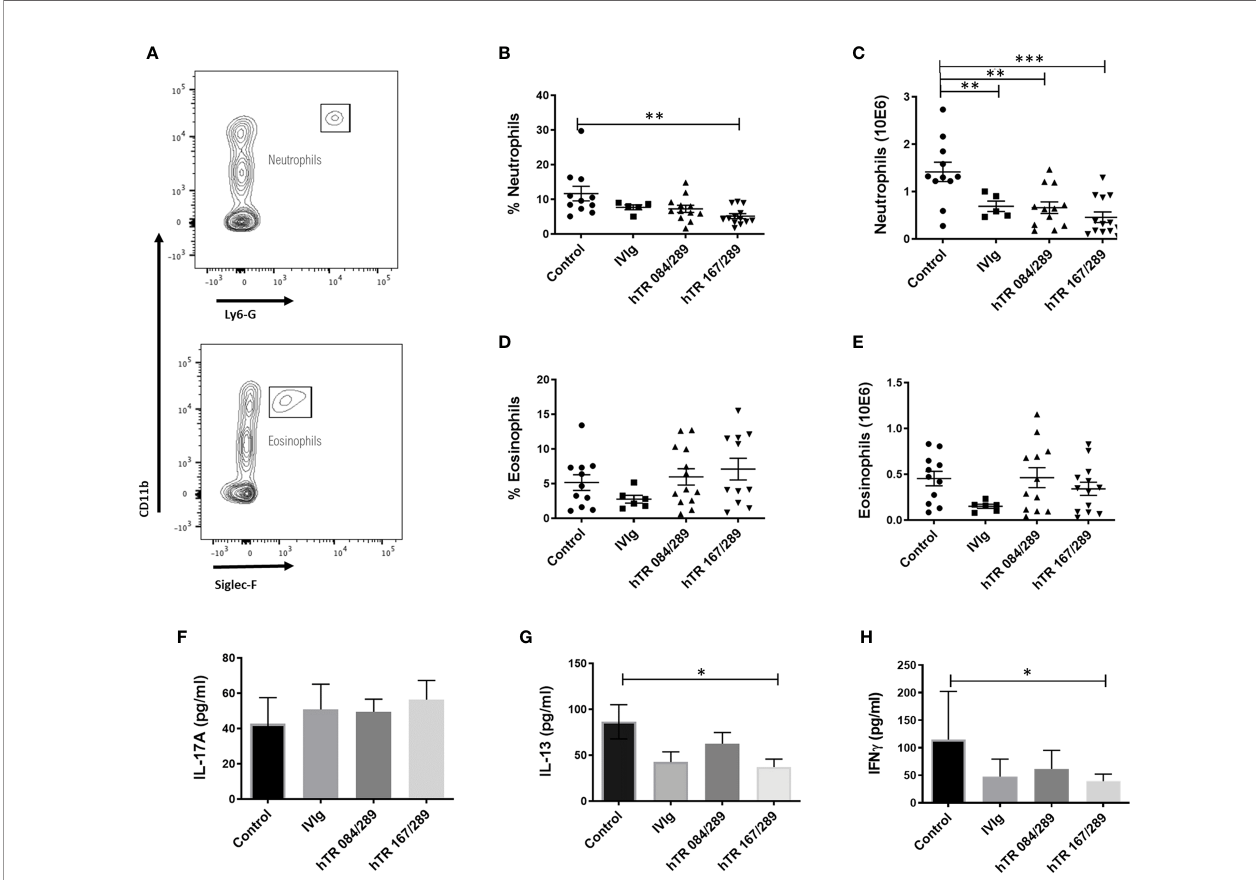
FIGURE 2 | Tregitopes modulate neutrophil and cytokine pro fi les of mice in OVA-driven murine allergic airways disease. Neutrophils and IL-13 are signi fi cantly reduced in the lungs of mice treated with IVIG or Tregitopes. (A) Gating strategy for lung neutrophils and eosinophils of OVA-allergic mice undergoing treatment with Control, IVIg, or hTR 084/289 and hTR 167/289. (B) Percentage and (C) absolute number of lung neutrophils. (D) Percentage and (E) absolute number of lung eosinophils (representative of 3 independent experiments, n = 5-13). (F) Cytokines concentration of IL-17A (G) IL-13 and (H) IFN g measured by ELISA in whole lung homogenates. ***p, 0.005, **p, 0.01, *p, 0.05, one-way ANOVA